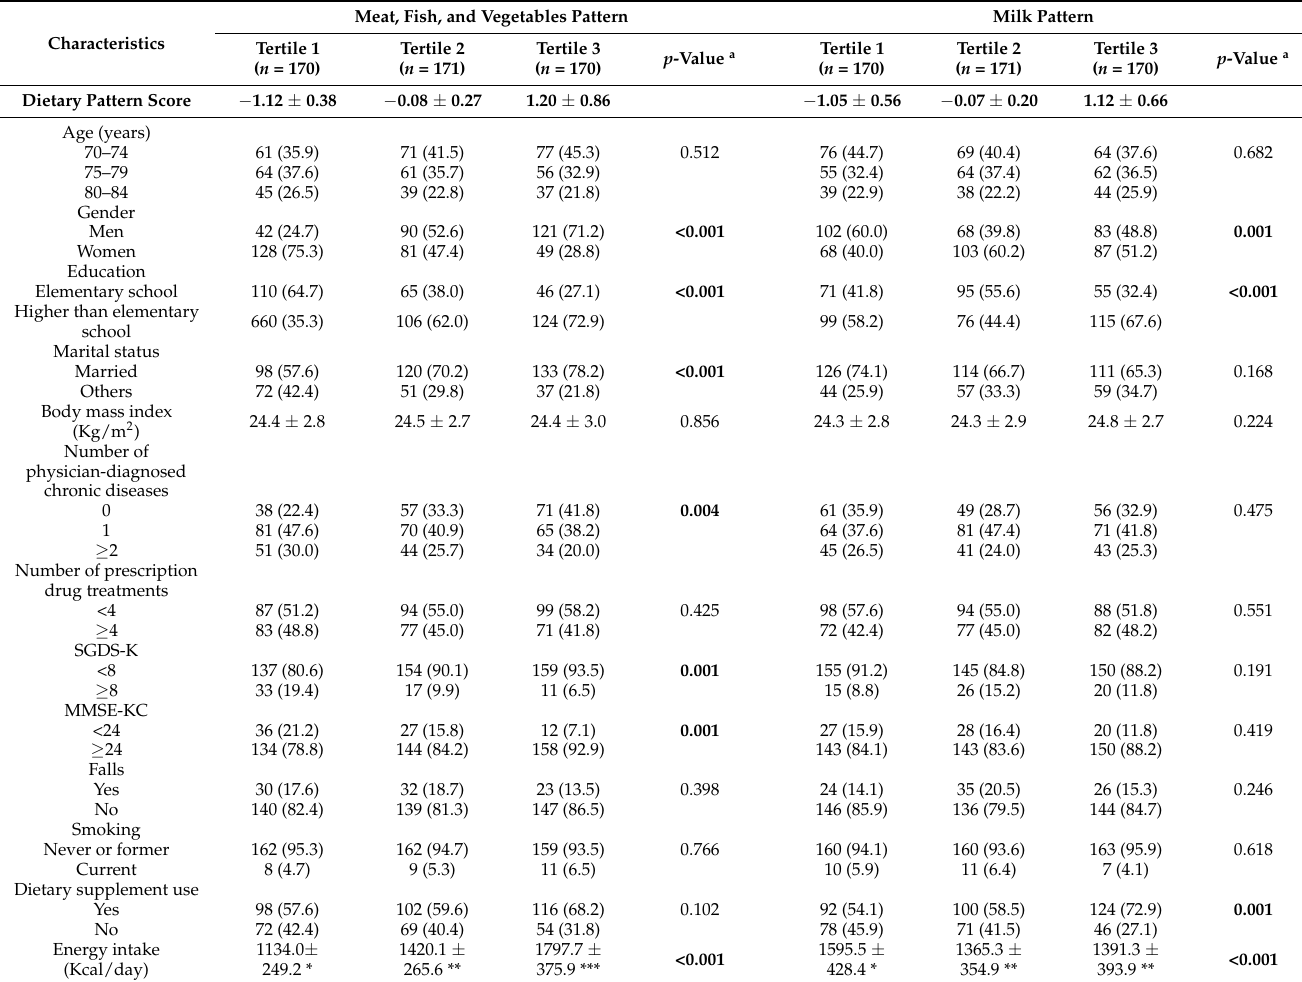
Table 2. Relationship between tertiles of dietary pattern scores and subject characteristics ( n =